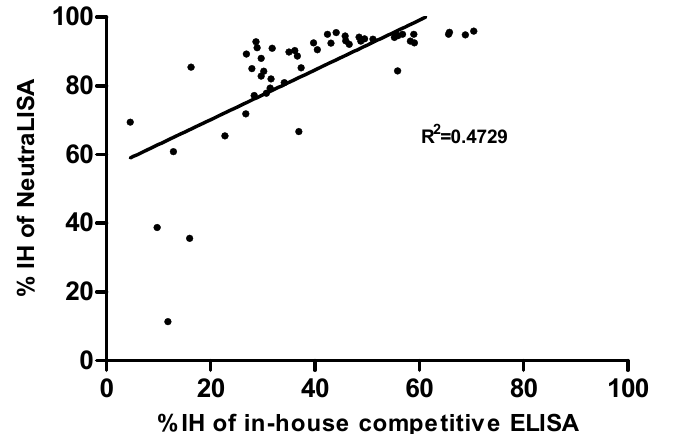
Figure 4. Correlation between the neutralizing antibodies against the RBD of SARS-CoV-2 by NeutraLISA and in-house competitive ELISA was analyzed using Pearson’s correlation coefficients. Statistical significance was calculated using the two-tailed test ( n = 50).